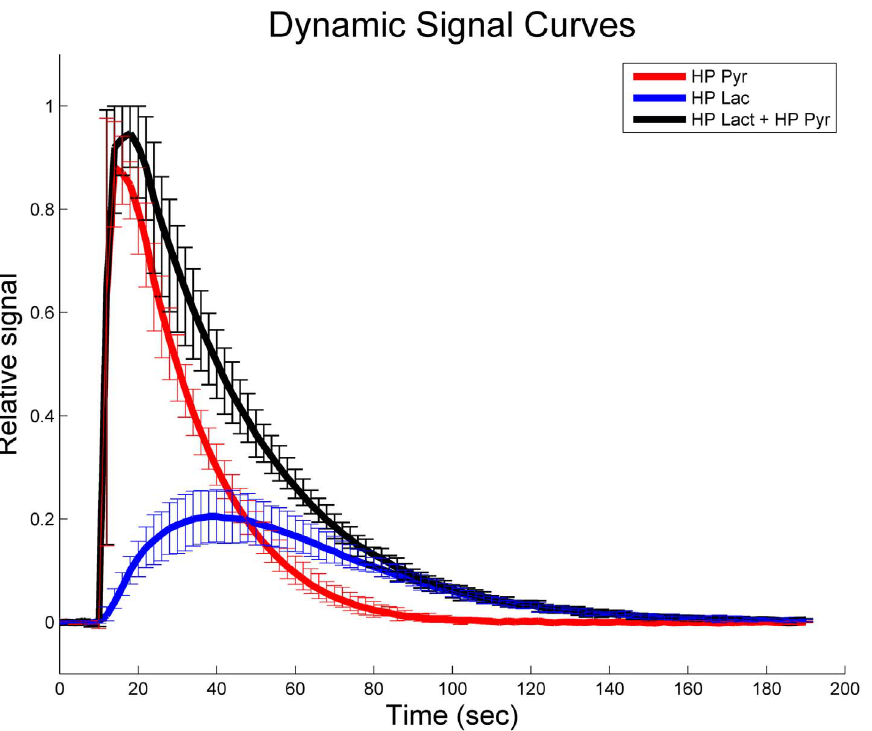
Figure 2. Dynamic signal evolution across (N=7) injections. The mean signal for lactate and pyruvate, normalized to peak carbon signal for each injection, are displayed with error bars that indicate the minimum and maximum values at each time over all injections. Total HP 13 C was estimated by summing signal from HP 13 C Lactate and HP 13 C Pyruvate. The average linewidth for pyruvate and lactate peaks were 19 6 5 Hz and 17 6 5 Hz, respectively.